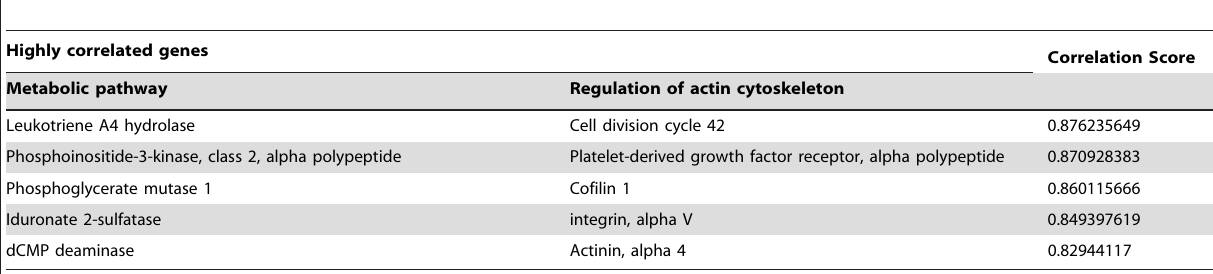
Table 6. Sample correlation scores of highly correlated genes (Metabolic and Regulation of actin cytoskeleton pathways).